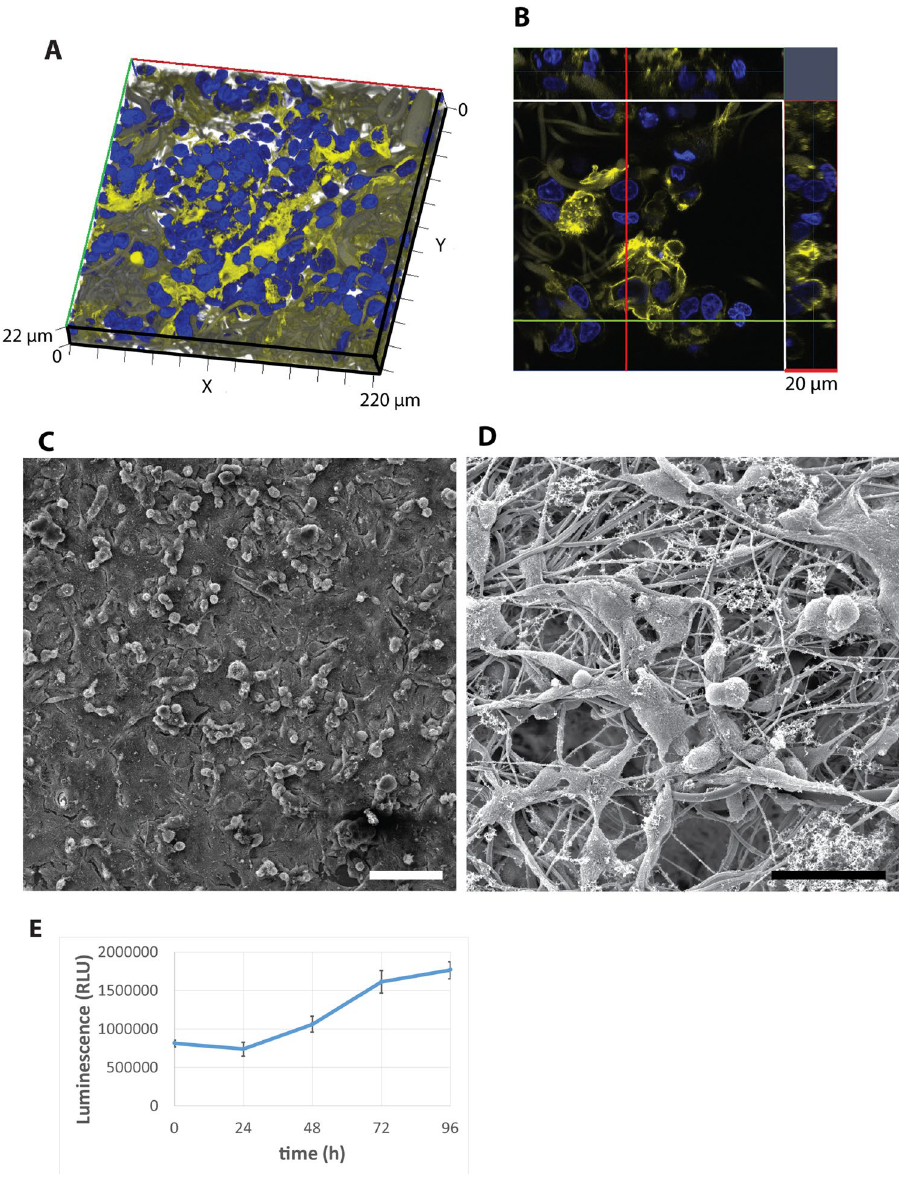
Figure 2. Hep G2 cells cultured on SBS mats for 96 h. ( A ) 3D reconstruction showing the Hep G2 cells grown on a SBS mat. ( B ) Ortho-view of the Hep G2 cells grown on a SBS mat. Actin cytoskeleton of cells was visualized by phalloidin staining (yellow), cell nuclei were stained with DAPI (blue). ( C,D ) SEM micrographs at different magnifications of the surface of mats populated with Hep G2 cells. Scale bars are 100 µm ( B ) and 50 µm ( C ). ( E ) Cell viability assay of Hep G2 cells cultured on SBS mats for 96 h. RLU relative light units. Hep G2 cells were cultured in IMDM medium containing fetal bovine